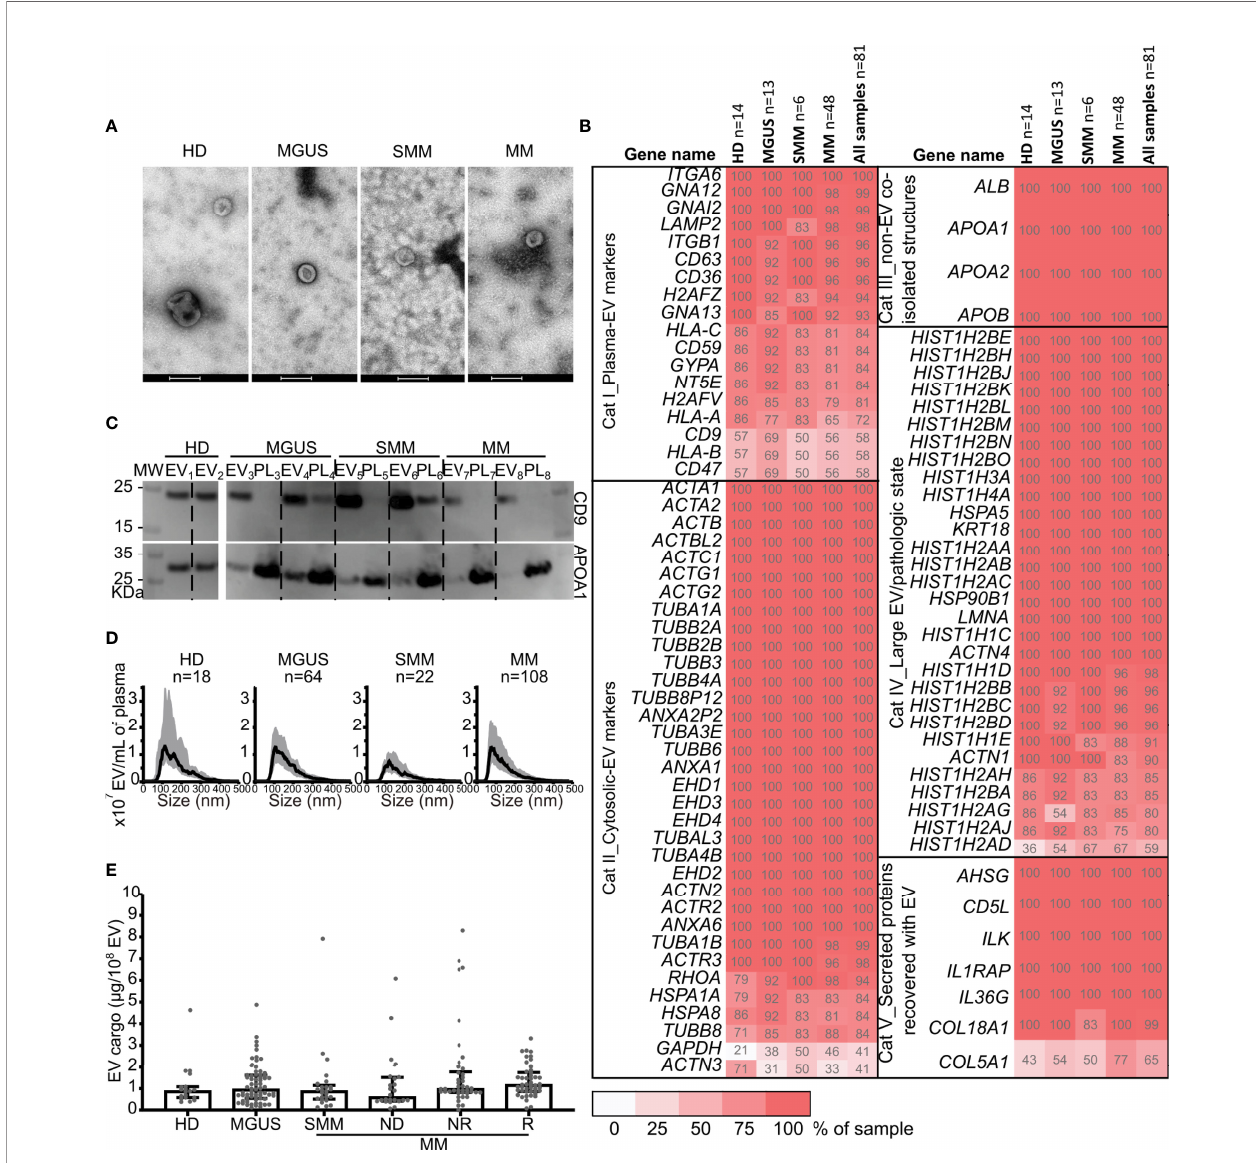
FIGURE 1 | Characterization of extracellular vesicles from patient peripheral blood according to diagnostic category. (A) Transmission electron microscopy of circulating EV from representative samples from HD, MGUS, SMM, and MM samples. Scale bar, 200 nm. (B) Positivity for conventional protein markers identi fi ed by mass spectrometry across patients ’ groups according to MISEV (3).The percentage of the samples expressing the speci fi ed protein is noted in each box. Dark red depicts a higher frequency. (C) Western blot analysis of CD9 and APOA-1 EV markers in EV samples and the source plasma (PL) sample. Two representative samples per group of diagnosis were tested. (D) Particle concentrations in plasma according to the size distribution from peripheral blood samples used in the present study (median and interquartile range). (E) EV cargo data distribution from peripheral blood samples according to the disease category at sample collection, HD (n=19 subjects, 19 samples), MGUS (n=38 patients, 67 samples), and MM (n=65 patients,137 samples): SMM (n=13 patients, 25 samples); ND (n=24 patients, 24 samples), NR, non-responder (n=32 patients, 42 samples), R, responder (n=27 patients, 46 samples). Using a linear mixed-effect model analysis, no signi fi cant differences between diagnostic categories (HD, MGUS, SMM, ND, NR, and R) were observed (p=0.39). HD, healthy donor; MGUS, monoclonal gammopathy of uncertain signi fi cance; SMM, smoldering multiple myeloma; NR, non-responder; R, responder, MM, multiple myeloma; EV, extracellular vesicle; PL, plasma; MW, molecular weight